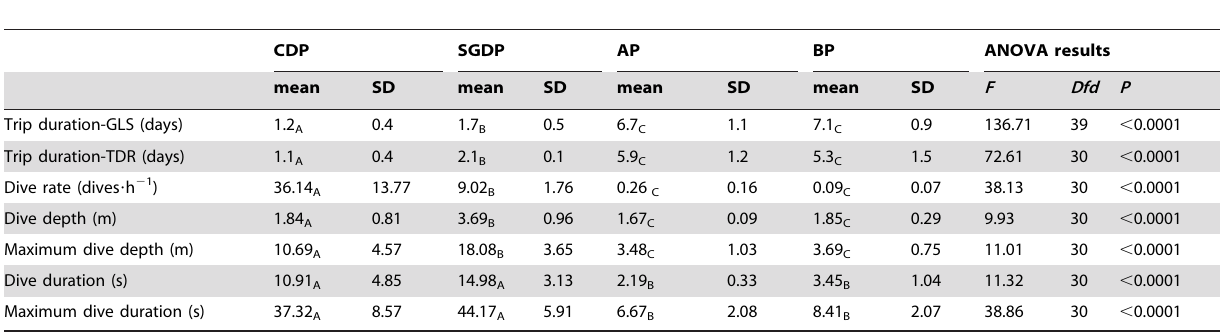
Table 1. Trip duration and diving characteristics (mean and standard deviation) of common diving petrels (CPD), South Georgian diving petrels (SGDP), Antarctic prions (AP) and blue petrels (BP) tracked with TDRs and GLS-immersion loggers during incubation at Bird Island, South Georgia, in summer 2010/11.